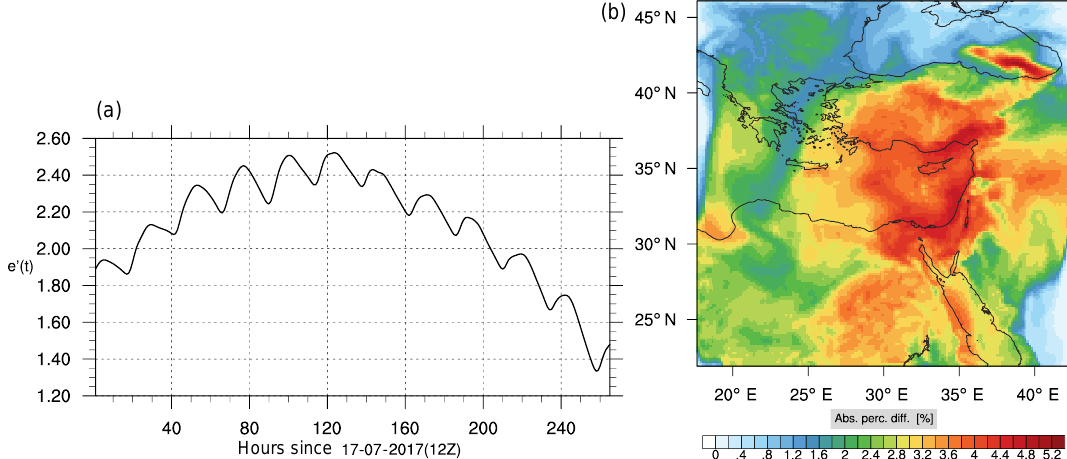
Figure 10. (a) The volume-weighted average of the absolute percentage difference between the full and skeletal mechanisms, e (cid:48) (t) , for the carbon monoxide mixing ratio. (b) The spatial distribution of the absolute percentage difference between the reduced and the full mechanisms, with respect to the full mechanism, for the CO mixing ratio when e (cid:48) (t) is